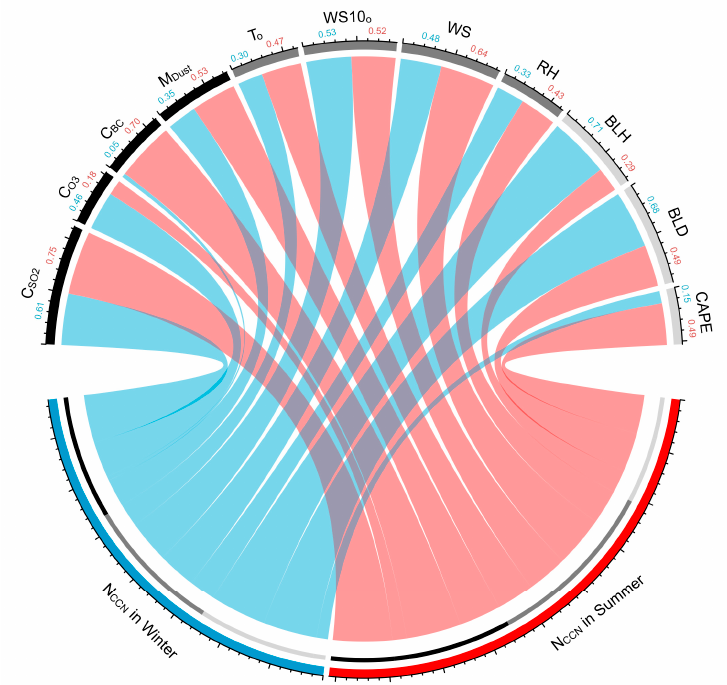
Figure 5. A chord diagram to display the correlation relationships (represented with the absolute value of r) between pollutants (black arcs of the circumference; C SO2 , C O3 , C BC and M Dust ), meteorological variables (dark grey arcs; T O , WS10 O , WS, and RH) and atmospheric stability variables (grey arcs; BLH, BLD and CAPE) and N CCN in summer (red arc) and winter (blue arc). The absolute values of r (numbers shown along the upper half circumference) denote the correlations between the corresponding variables and N CCN connected by the red/blue belt. The wider belt indicates the stronger correlation between the individual variable and N CCN